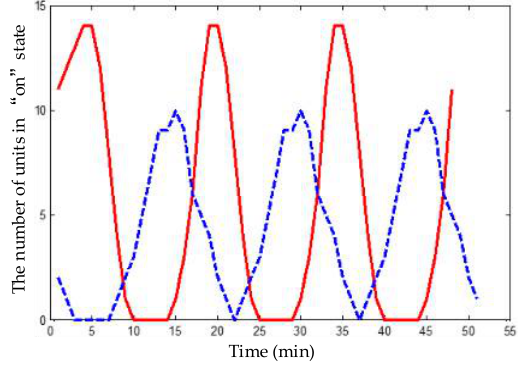
Figure 4. Load fluctuation curve.